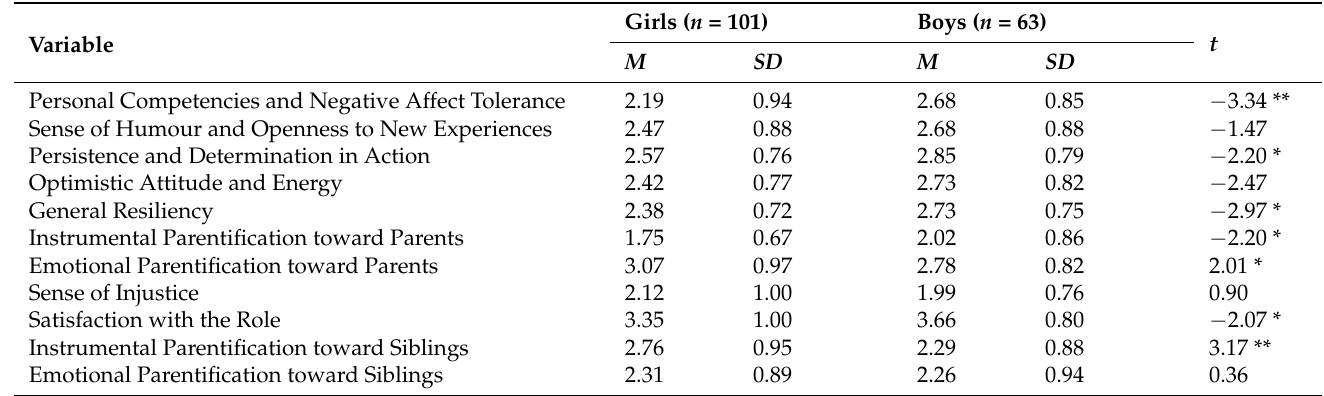
Table 2. Gender Dfferences in Study Variables ( N = 164).